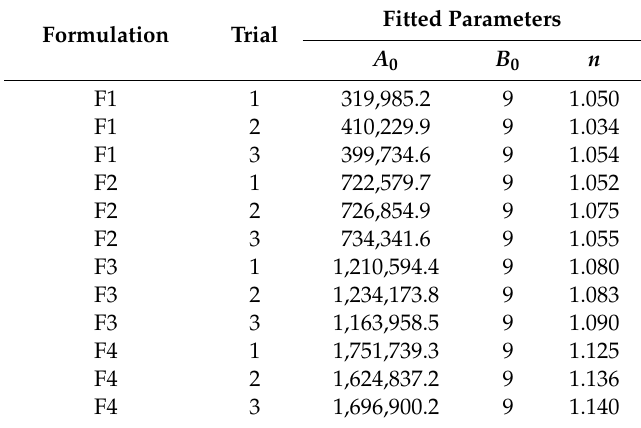
Table 2. Coe ffi cients from the fits of Malkin’s model with the measured values. Table 2. Coefficients from the fits of Malkin’s model with the measured values. Fitted Parameters Fitted Parameters Formulation Trial Formulation Trial A